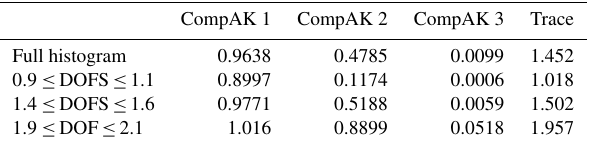
Table 2. Average information content for each mode of the aver- aging kernel for the entire study period. CompAK 1 denotes the average information in mode 1, CompAK 2 is for mode 2, and so forth. Trace denotes the total information content. “Full histogram” means all retrievals were considered. DOFS denotes the degree of freedom for the signal, and the different DOFS rows identify the average information content for the different DOFS ranges and av- eraging kernel